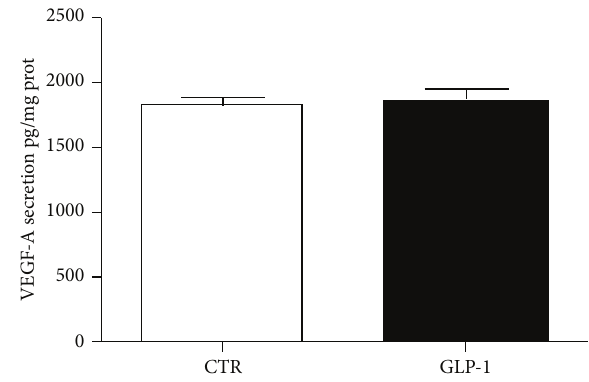
Figure 7: GLP-1 does not affect secretion of VEGF-A. ARPE-19 cells were cultured for 24 h in in the presence or absence of 10nmol/L GLP-1. The conditioned media were collected, and VEGF-A levels in supernatants were assessed by ELISA. VEGF-A concentration was calculated from standards curve and normalized to total protein concentration of the respective lysates. The results are representative of three independent experiments (mean ±